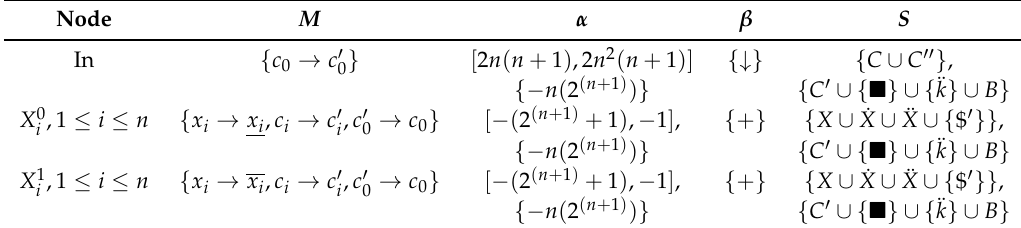
Table 2. Internals of the In node and nodes of the subnetwork Gen .